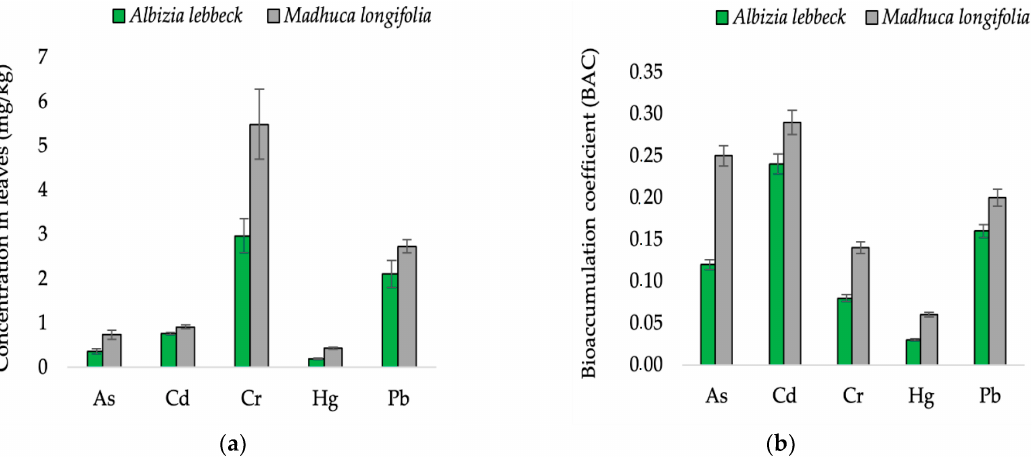
Figure 1. ( a ) Concentration of potentially toxic elements in plant leaf ( n = 10 per species) grown on the reclaimed soil of Jharia Coalfield, and ( b ) bio-accumulation coefficient (BAC) of potentially toxic elements for plant